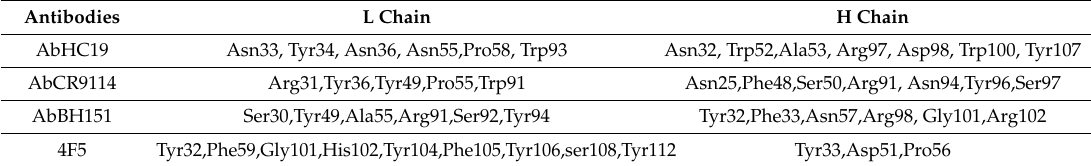
Table 2. Definition of binding sites for each antibody, based on our MFMD